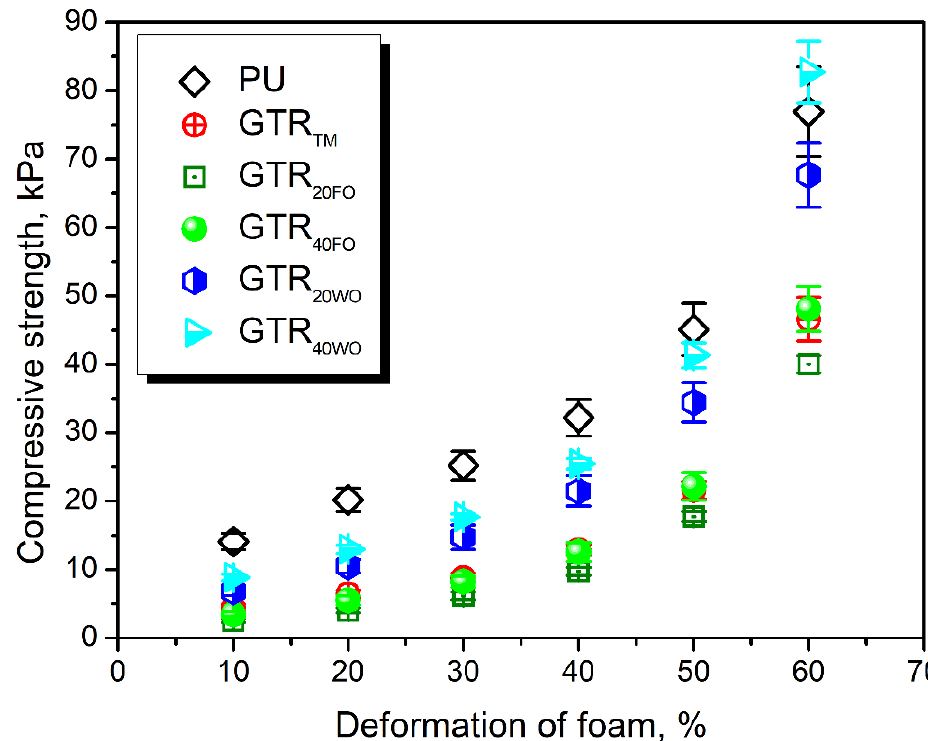
Figure 3. Compressive strength of prepared foams at varying deformation.